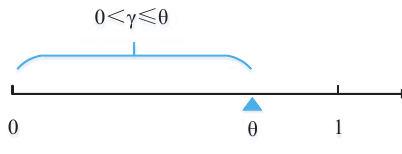
Figure 4. The acceptable service price range for a user equipment (UE) with θ